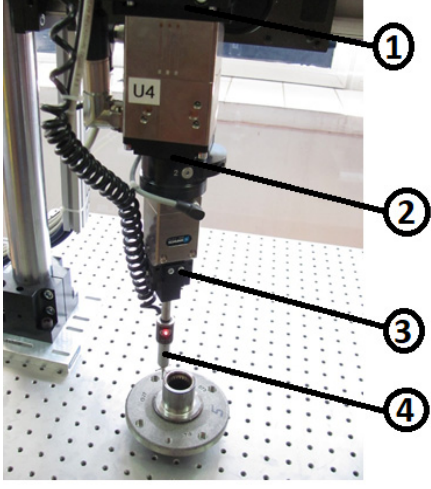
Figure 5. MMI4D subsystem. Legend: 1—linear electrical system Z; 2—electric rotation system R; 3—electric gripper electric system; 4—highly-precise 3D probe.